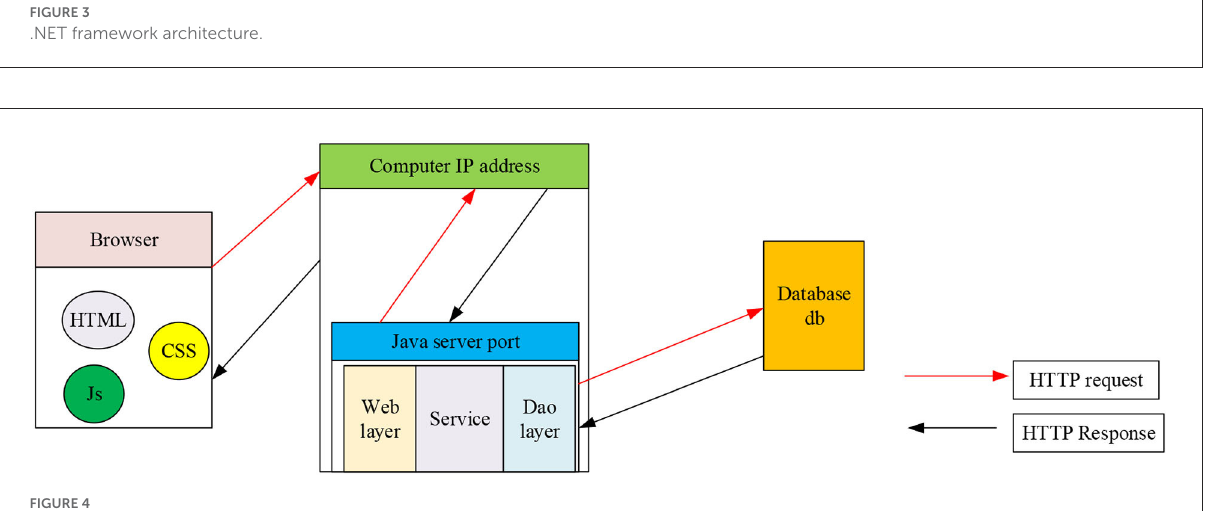
FIGURE4 B/S structure